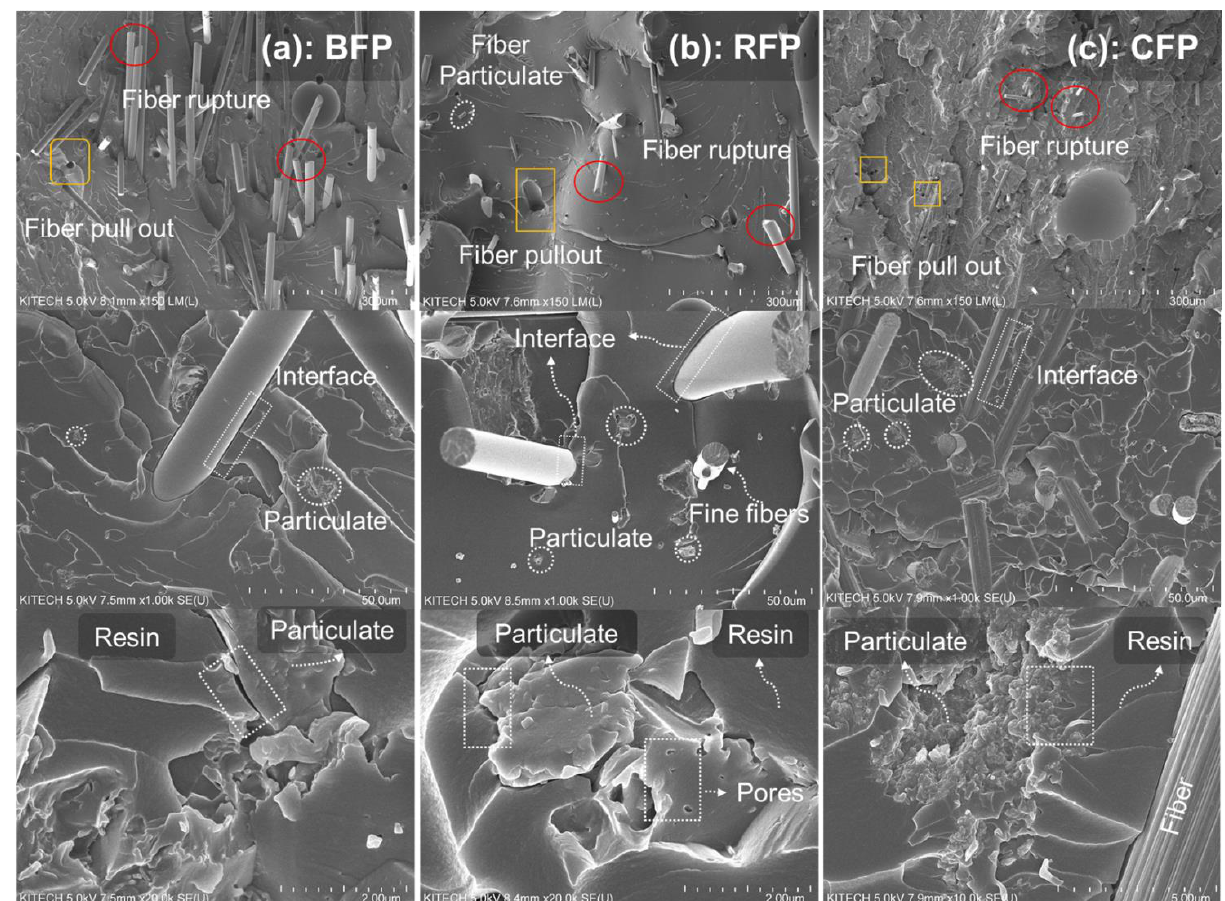
Figure 8. SEM images of the composites ( a ) Basalt composites, ( b ) Rockwool composites, and ( c ) Carbon composites. Fiber pull out, fiber interface, fiber particles, and particle interface are highlighted in the Figure.